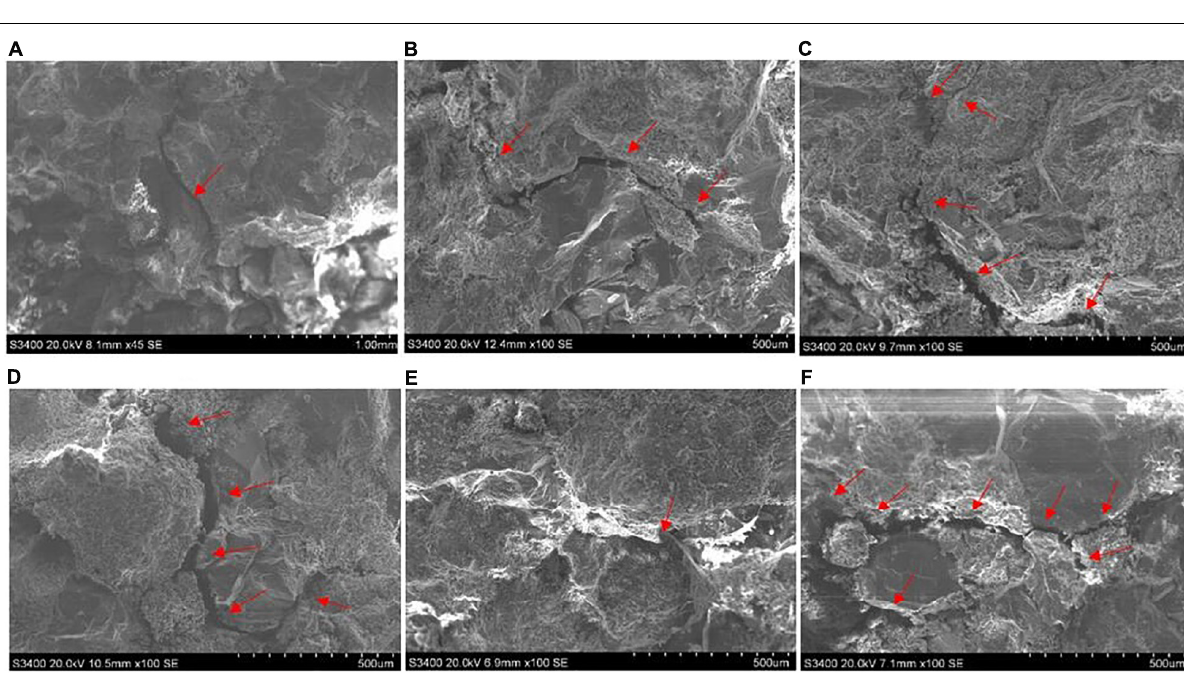
FIGURE 8 | Representative SEM images of gritstone after different HTHP treatments: (A) original specimen; (B) specimen 10M1; (C) specimen 30M1; (D) specimen 50M1; (E) specimen W1; (F) specimen WP1. Red arrow indicates the